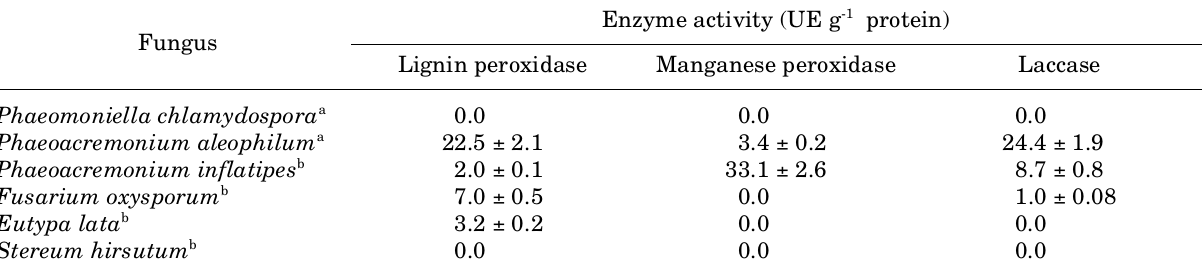
Table 1. Lignin peroxidase, manganese peroxidase and laccase specific activity (UE g -1 protein) in the fungi in- volved in Petri disease (a) and in fungi implicated in other trunk grapevine diseases (b). Data correspond to mean ± SE (n=3).